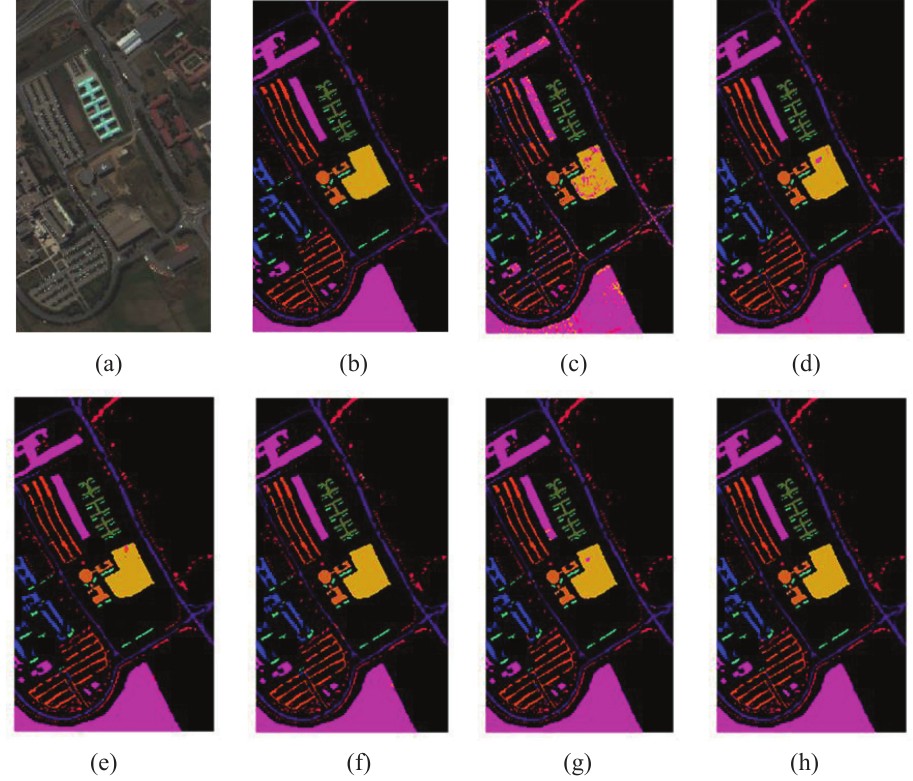
Figure 10. Classification maps provided for the University of Pavia data set by different methods. ( a ) A false color map. ( b ) The ground truth map. ( c ) CNN (85.89%). ( d ) M3DCNN (99.03%). ( e ) SSRN (99.19%). ( f ) MSDN-SA (99.31%). ( g ) MSO3DCNN (99.54%). ( h ) CSA-MSO3DCNN